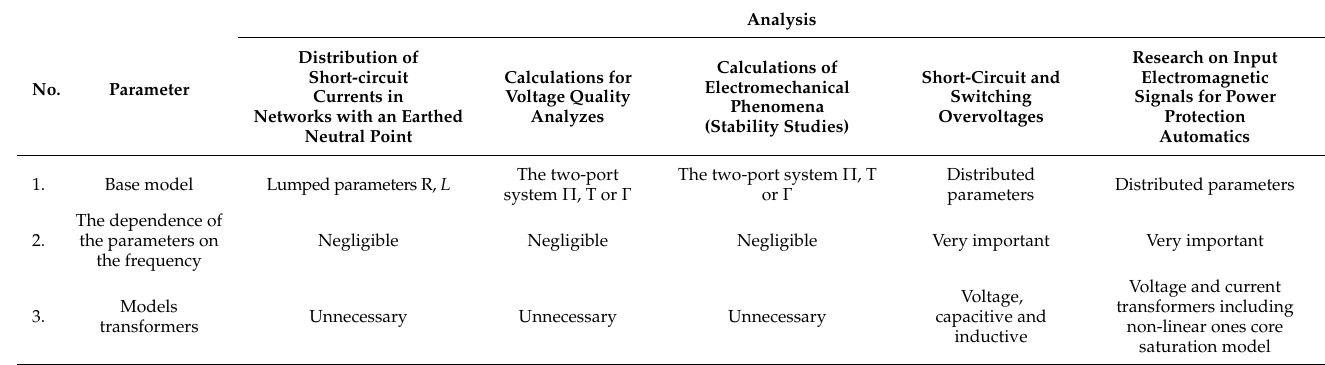
Table 2. Requirements of the transmission line model depending on the purpose of the research